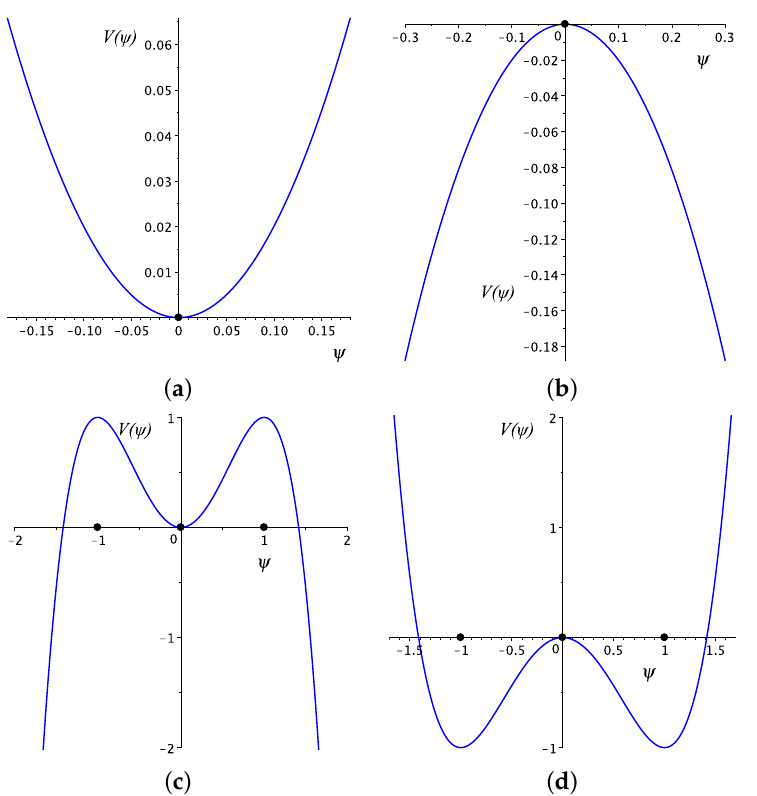
Figure 1. The potential function (16) for different values of ρ 1 and ρ 2 , the black solid circles indicate the equilibrium points. ( a ) ρ 1 = 2, ρ 2 = 1; ( b ) ρ 1 = − 2, ρ 2 = − 1; ( c ) ρ 1 = 2, ρ 2 = − 1; ( d ) ρ 1 = − 2, ρ 2 =